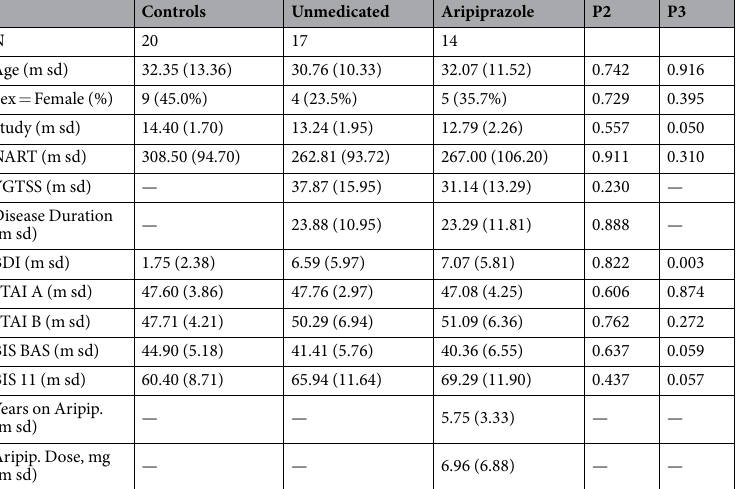
Table 1. Demographic characteristics and psychometric scales for participants by treatment group. The “p2” p-values correspond to the comparison between the unmedicated and aripiprazole groups (two- sample t-test). The “p3” p-values correspond to the comparison among all three groups (one-way analysis of